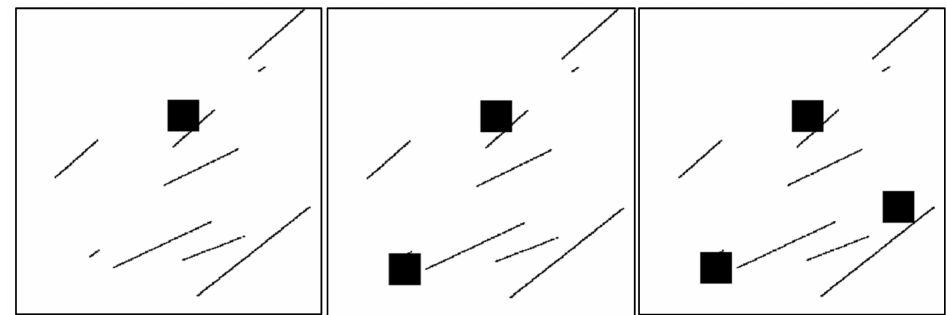
Figure 6. The fracture models with low fracture density and big